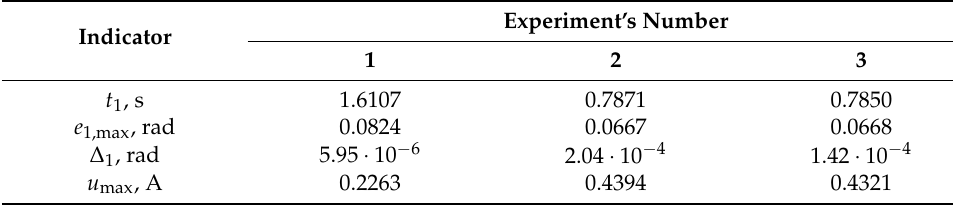
Table 2. Values of performance indicators of closed-loop